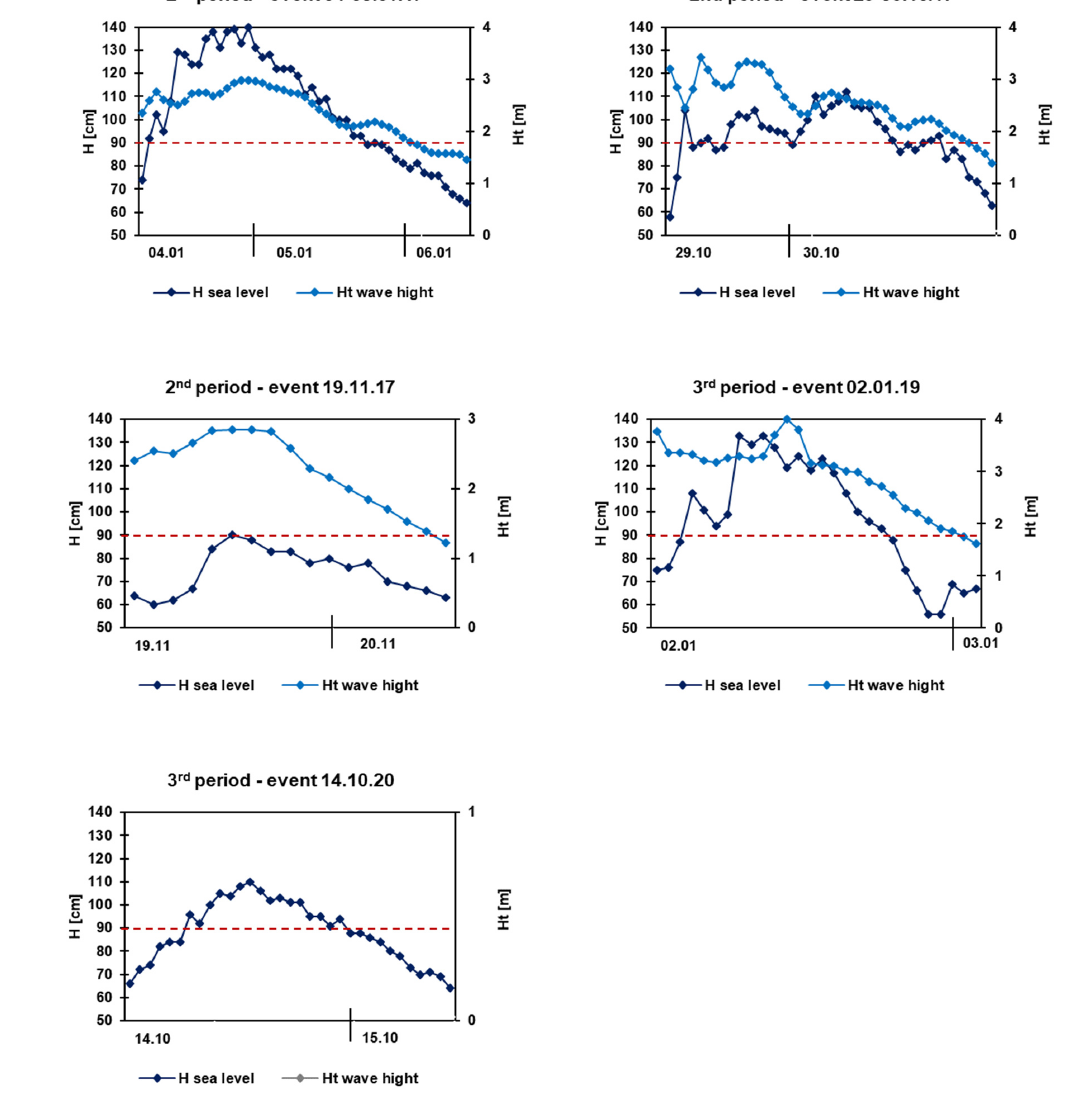
Figure 5. Sea hydrodynamics parameters (maximum sea level and high of wave) during storm surges on H max ≥ 90 cm N.N. (2012–2020 ´Swinouj´scie). Raw data source—Institute of Meteorology and Water Management, Interdisciplinary Modeling Center of the University of Warsaw.